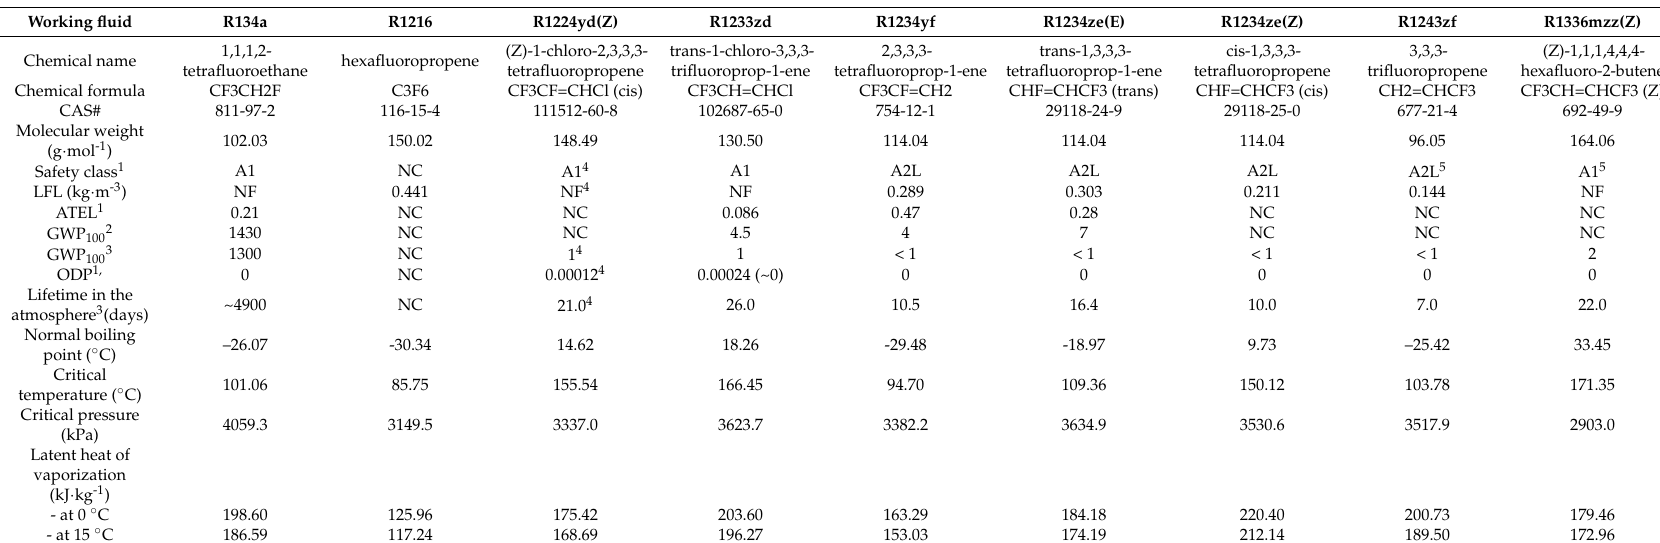
Table 1. Chemical and physical properties of HFO and HCFO refrigerants